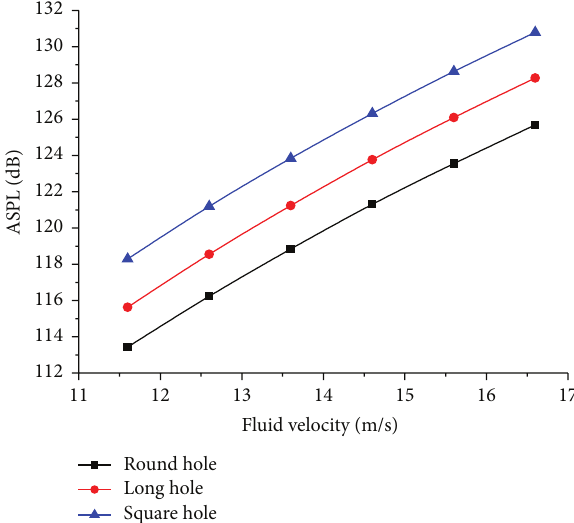
Figure 18: Relationship between fluid velocity and THR. Figure19:RelationshipbetweenthefluidvelocityandASPLinthree grid forms.